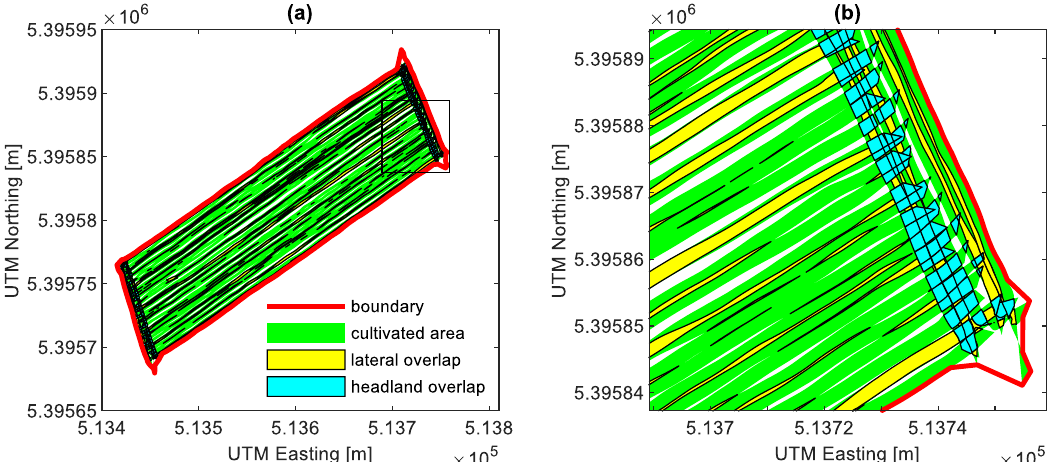
Figure 16. ( a ) Field boundary, cultivated area and lateral and headland overlaps; and ( b ) a zoomed area at the lower northeast corner of the field.